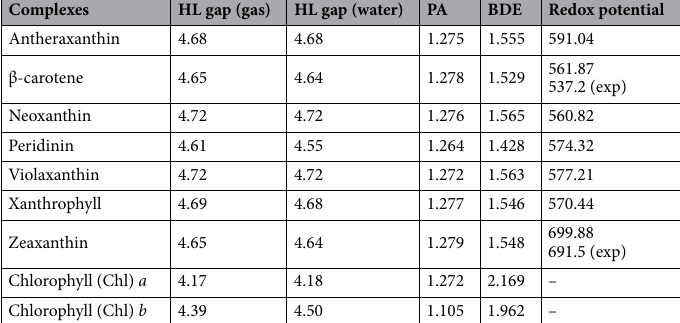
Table 2. Calculated HOMO–LUMO Gap (eV) (gas, water), Proton affinity (PA), bond dissociation energies (BDE) and redox potential (meV) for studied carotenoid complexes and chlorophyll with wB97xD/6-31G**, wB97xD/Lanl2dz:6-31G** method